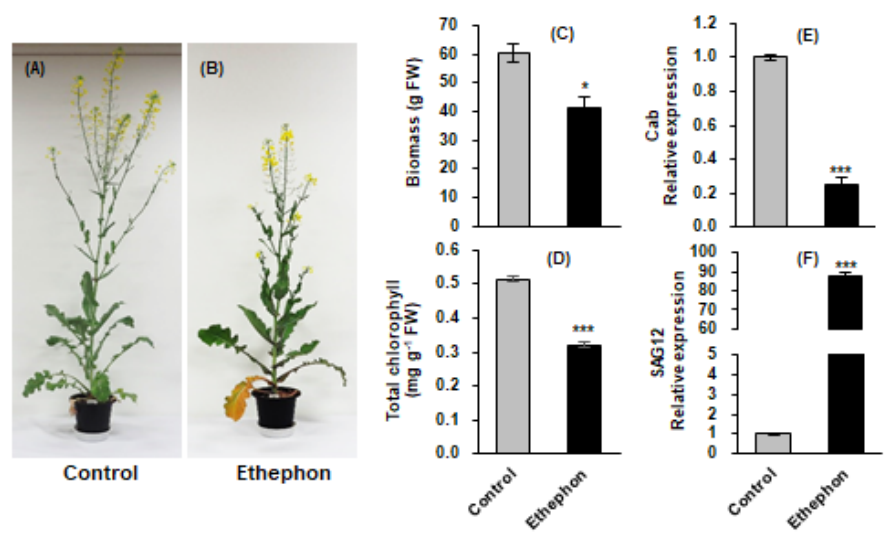
Figure 1. Plant morphology ( A , B ), biomass ( C ), total chlorophyll content ( D ), and Cab ( E ) and SAG12 ( F ) gene expression in mature leaves in control or ethephon-treated plants for 10 days. Data are presented as mean ± SE (n = 3). The qRT-PCR was performed in duplicate for each of the three independent biological samples. Signi fi cant differences between treatments are represented by * P < 0.05, *** P < 0.001.